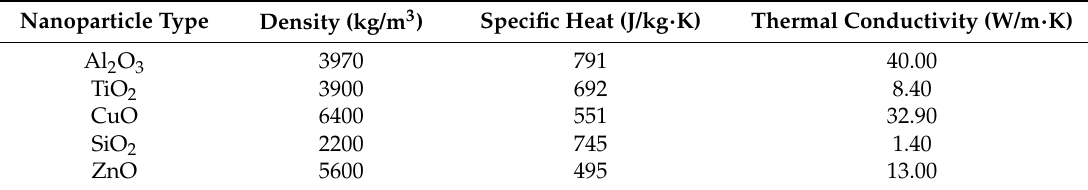
Table 4. Thermophysical properties of different nanoparticles types.